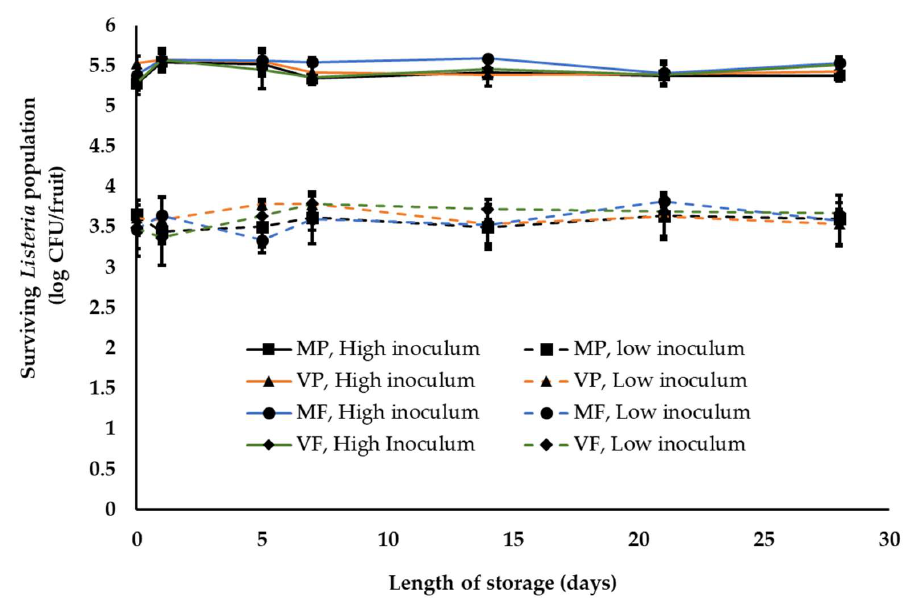
Figure 4. Listeria survival on peaches following fruit waxing and fungicide application and refrigerated storage under simulated packinghouse conditions (temperature—1–2 ◦ C, RH—85–95% (ambient humidity) and length of storage—3 to 4 weeks) at high (~5 log CFU/fruit) and low (~3 log CFU/fruit) pathogen load. Fruit finish formulations used in the study include MP, mineral oil + propiconazole; VP, vegetable oil + propiconazole; MF, mineral oil + fludioxonil; and VF, vegetable oil + fludioxonil. Data are represented as the mean ± SE.